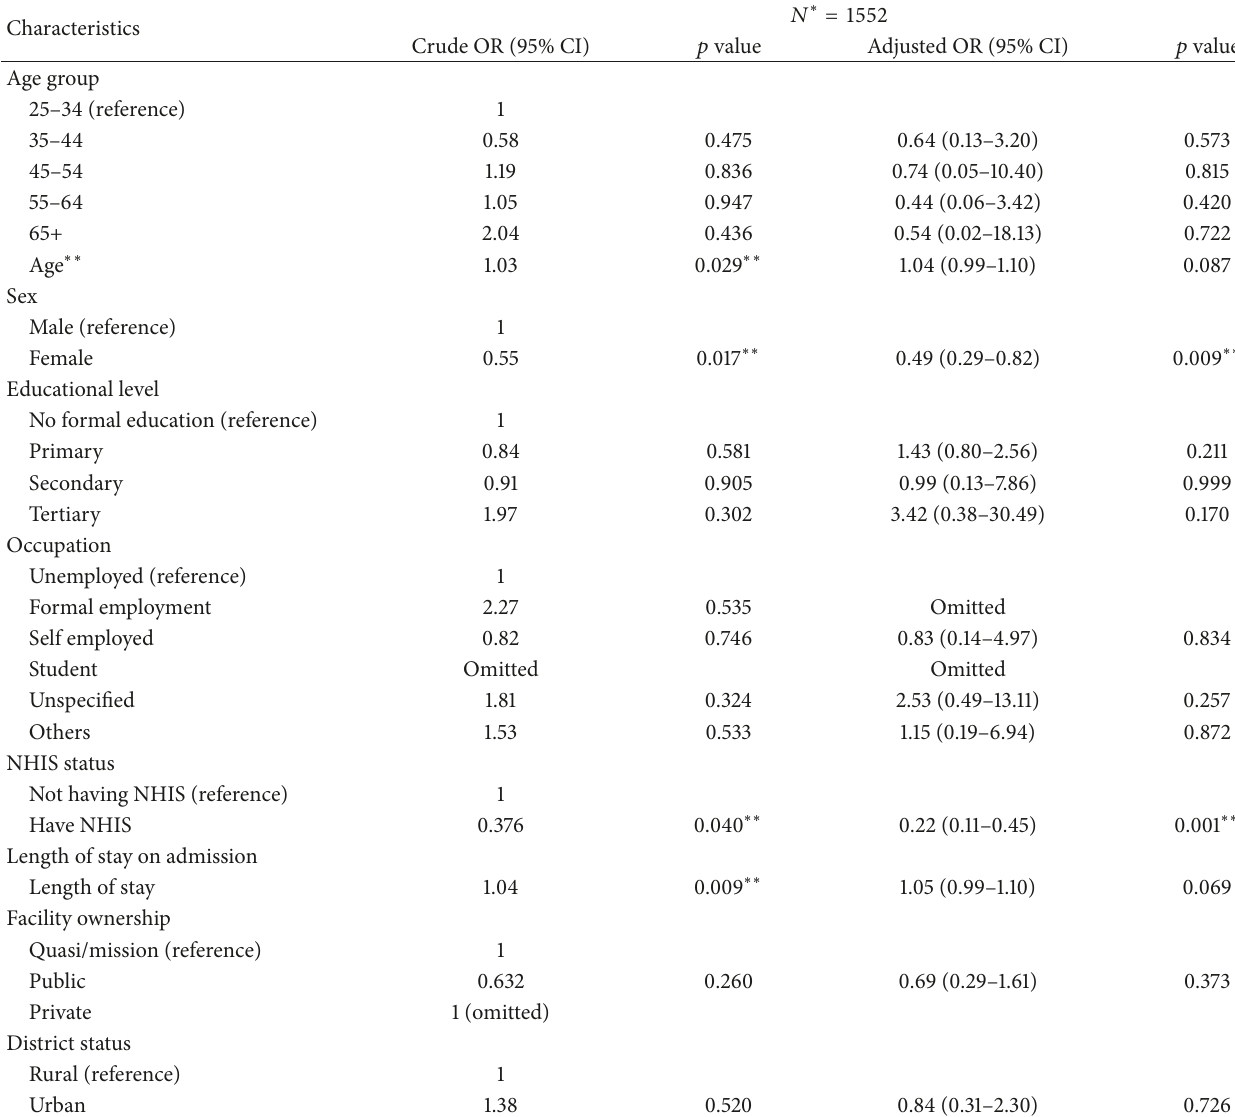
Table 3: Univariable and multivariable logistics regression analysis for the association between outcome of admission and sociodemographic characteristics of inpatient admissions of